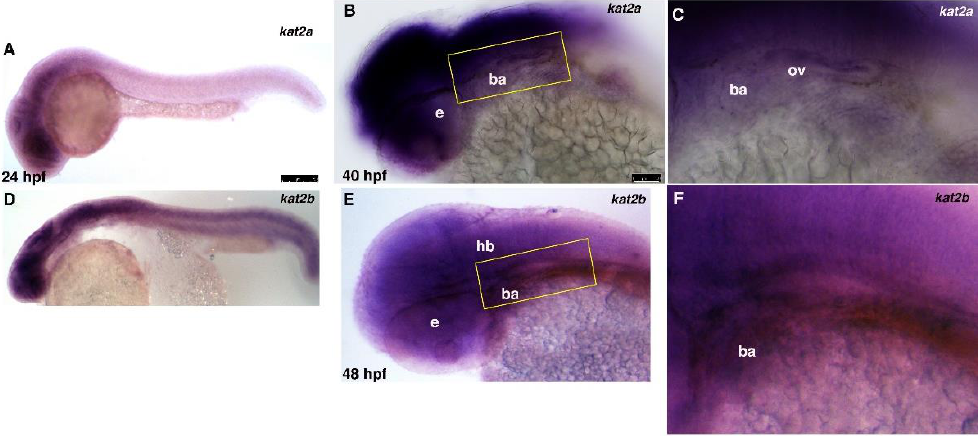
Figure 1. kat2a and kat2b are broadly expressed throughout the head region during zebrafish development. ( A – F ) Whole-mount in situ hybridization (ISH) of kat2a and kat2b expression during zebrafish development. Wildtype zebrafish embryos express both kat2a and kat2b in the head region, including the brain, the branchial arches, and the eye. ( A , D ) Lateral views at 24 h post fertilization (hpf) of expression of kat2a and kat2b . ( B , C ) Lateral views of wildtype embryos at 40 hpf shows kat2a expression in the eye, the branchial arches, and the otic vesicle. ( E , F ) Dorsal view at 48 hpf shows kat2b expression in the eye, the branchial arches, and the hindbrain. Lateral views, anterior is to the left. Yellow rectangles in B and E represent the regions shown in C and F, respectively. e, eye; ba, branchial arches; hb, hindbrain; ov, otic vesicle. Scale bars represent 250 μm ( A , D ) and 100 μm ( B , E ).